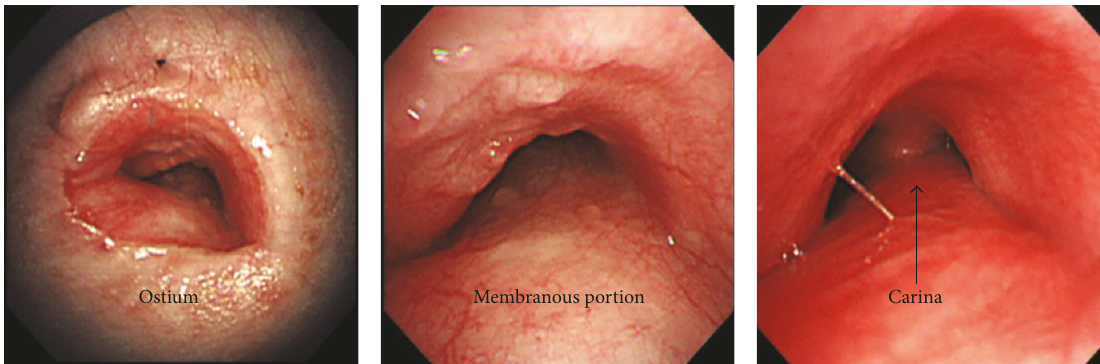
Figure 4: Bronchoscopy findings 6 months after the